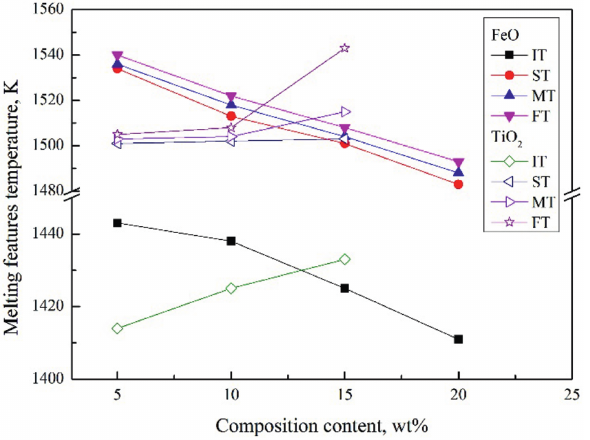
Figure 4: Effect of FeO and TiO 2 on the melting features of slag.